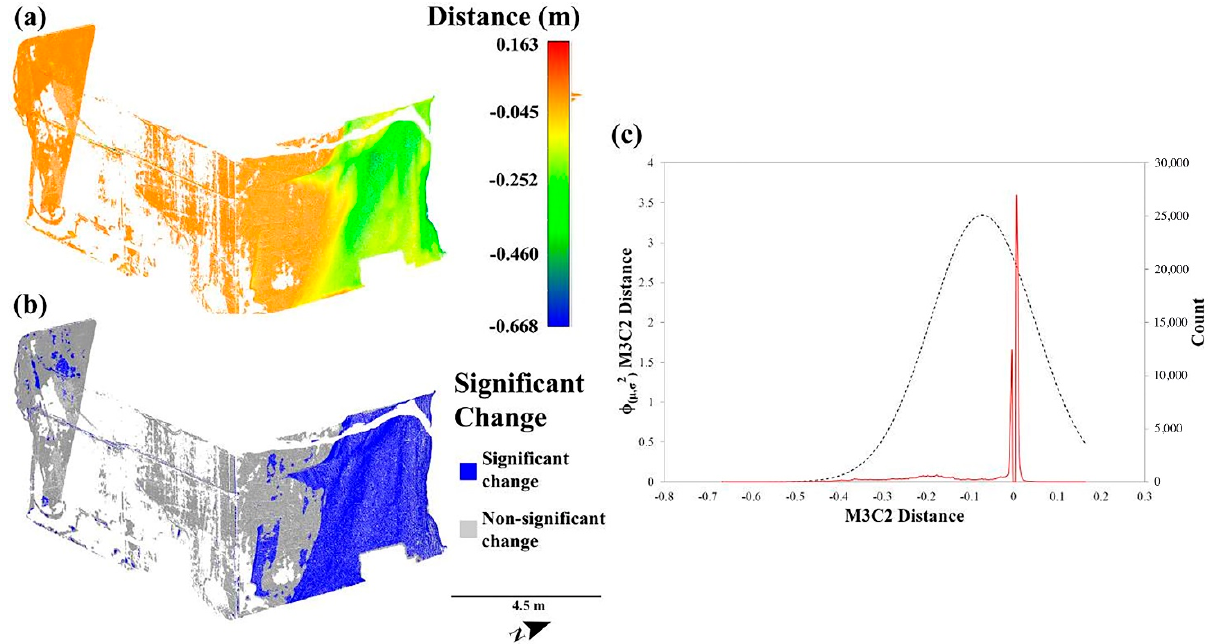
Figure 6. Maps of the computed distance ( a ) and significant change ( b ) in the analysed damaged pillar; the scale bar is indicative only due to perspective view. Gaussian distribution ( ϕ ( μ , σ 2) ) of computed distances (m) corresponding to significant changes ( c ).